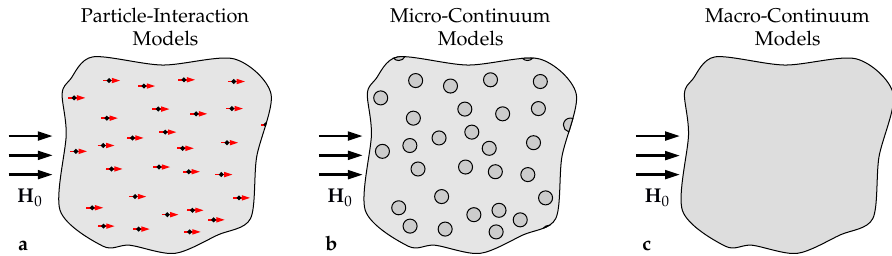
Figure 1. Illustration of different modeling strategies for MAEs: ( a ) particle–interaction models with dipolar magnetic particles (red arrows) distributed in an elastomer matrix (light gray background), ( b ) micro-continuum models with fully resolved particles (dark gray circles) within the same matrix, and, ( c ) homogeneous macro-continuum models with no resolution of the underlying